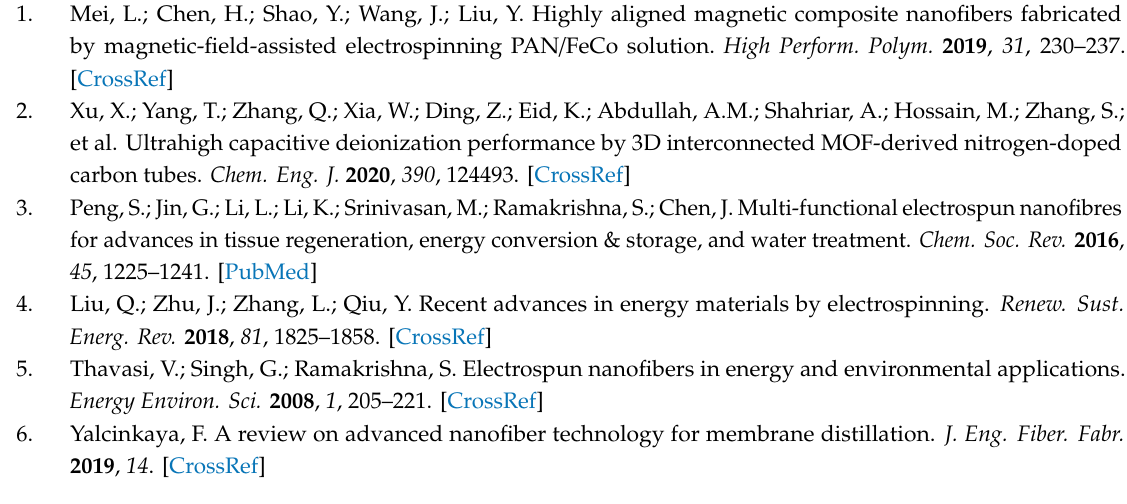
Figure 6c. The tested micro-nano fiber membrane has an average thickness of about 2 mm and an average weight of 0.3 g / m 2 . It can be seen that the composite fibers fabricated by MES with a magnetic field strength of 93 mT and γ -Fe 2 O 3 content of 1 wt % (sample D in the blue line of Figure 6c) exhibit the best electromagnetic shielding performance, which is almost tenfold that of pure PVP fibers. There are some strange “jumps” in some of the curves, which may be due to the unevenness of the device sensitivity and the impact of the agglomerated nanoparticles on the surface of the nanofiber